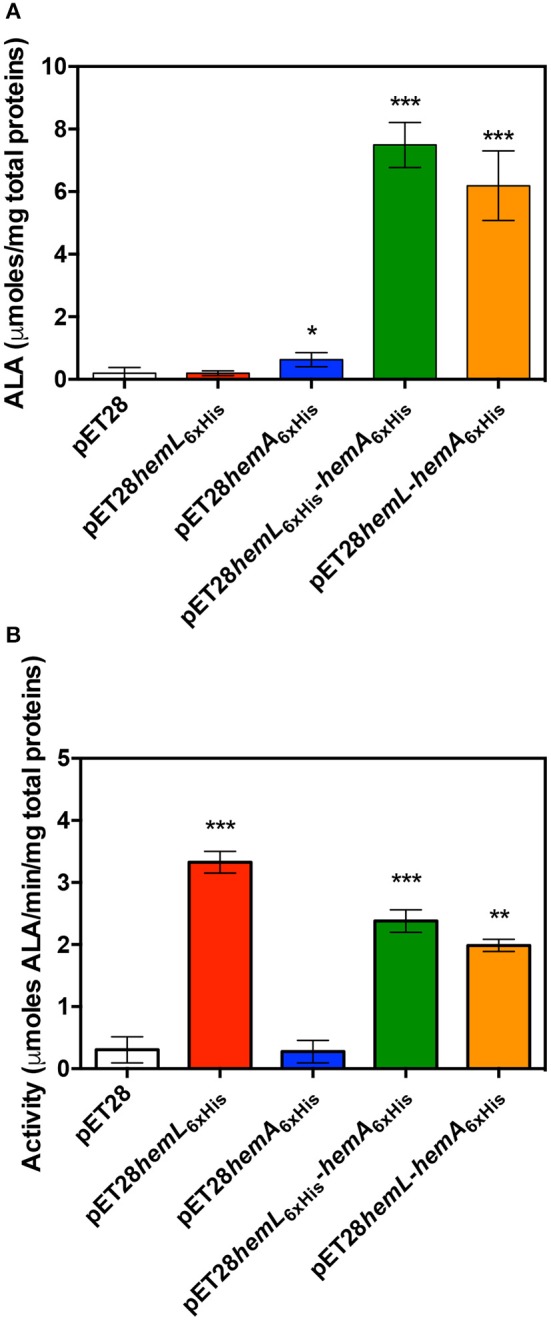
Effect of AbHemL and AbHemA overexpression. Content of ALA (A) and HemL activity (B) measured in lysate from E. coli BL21(DE3) containing the empty vector pET28, pET28hemL6xHis, pET28hemA6xHis, pET28hemL6xHis-hemA6xHis, and pET28hemL-hemA6xHis. Reported values are the mean ± standard deviation of four independent measurements. *P < 0.05, **P < 0.005, and ***P < 0.0005. Differences between HemL activity of strains containing pET28hemL6xHis-hemA6xHis and pET28hemL-hemA6xHis with respect to strain containing pET28hemL6xHis are statistically significant (P < 0.05).